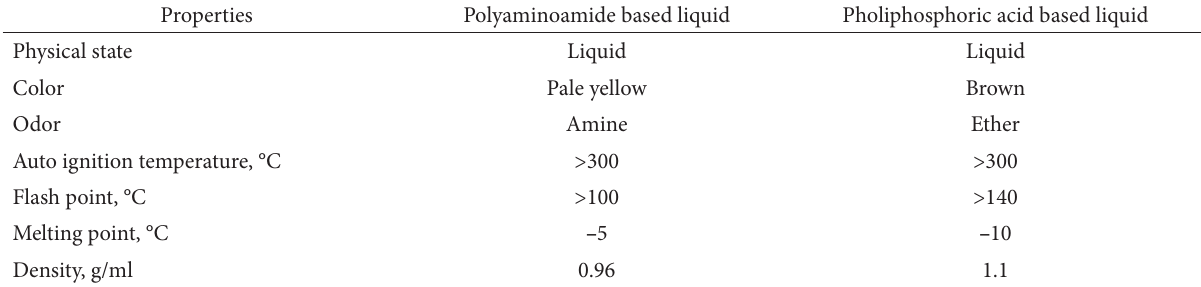
Table 3. Typical physical and chemical properties of anti-stripping additives